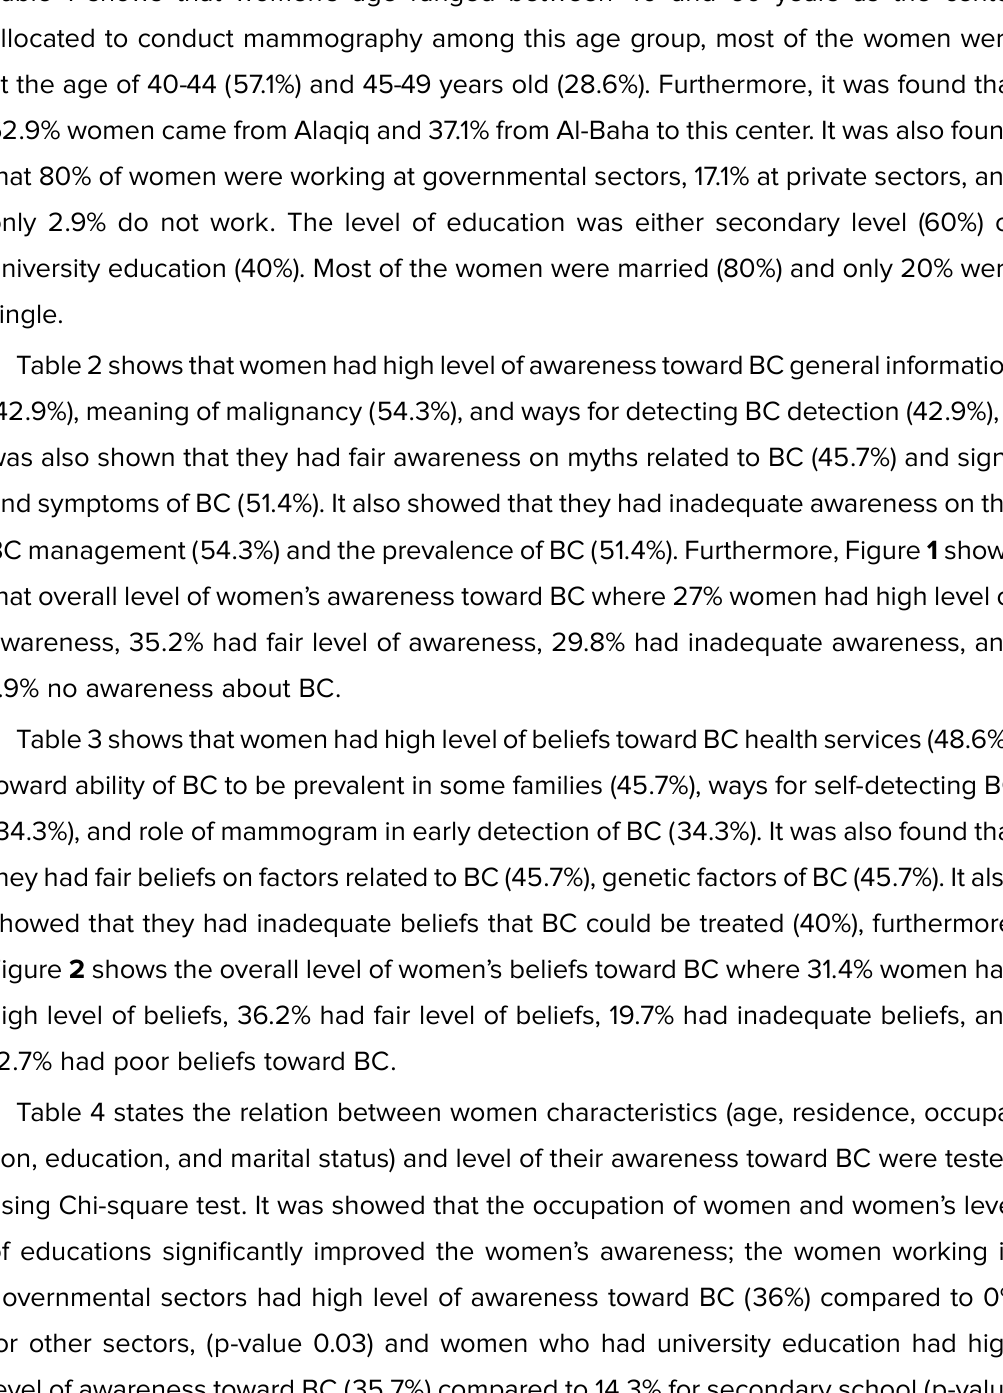
level of awareness toward BC (35.7%) compared to 14.3% for secondary school (p-value